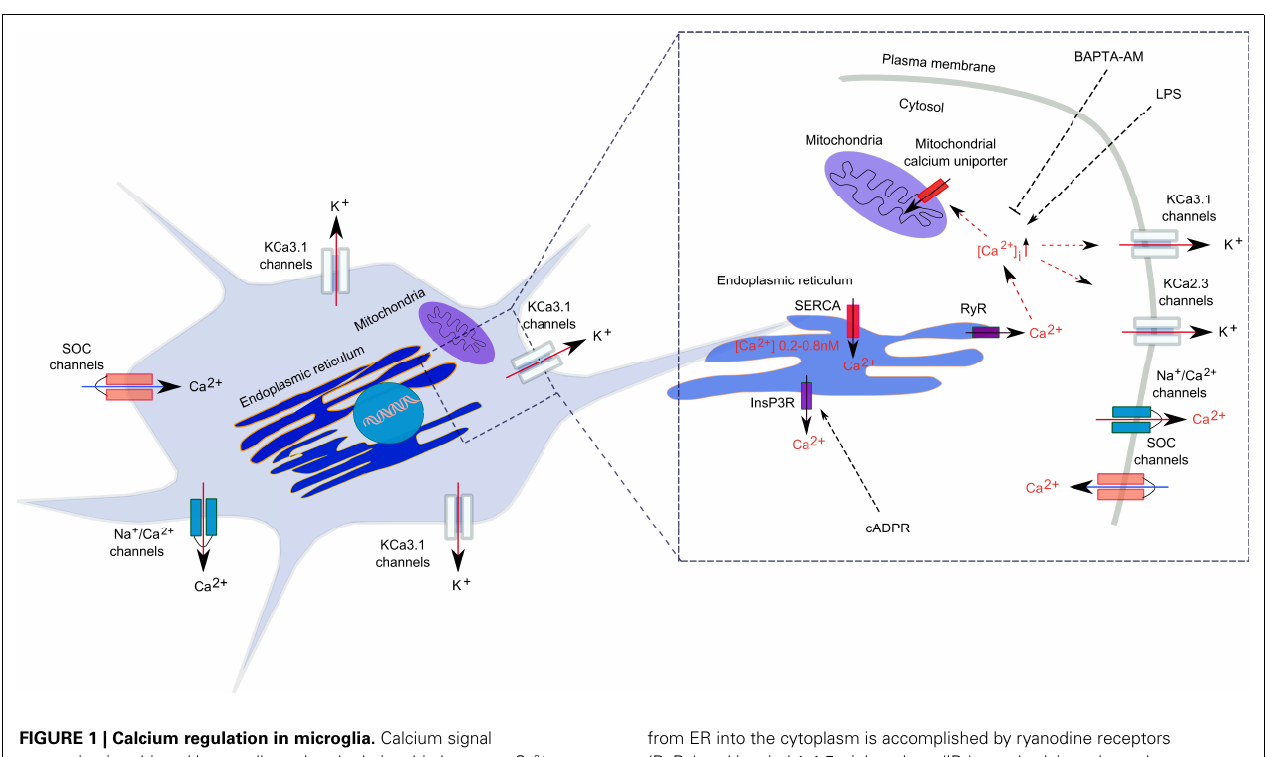
FIGURE 1 | Calcium regulation in microglia. Calcium signal generation is achieved by a well-regulated relationship between Ca 2 + release from the intracellular stores and the Ca 2 + entry through plasmalemma. In the ER, sarcoendoplasmic reticulum Ca 2 + -ATPases (SERCA) transfer Ca 2 + to the lumen of the ER, while the Ca 2 + release